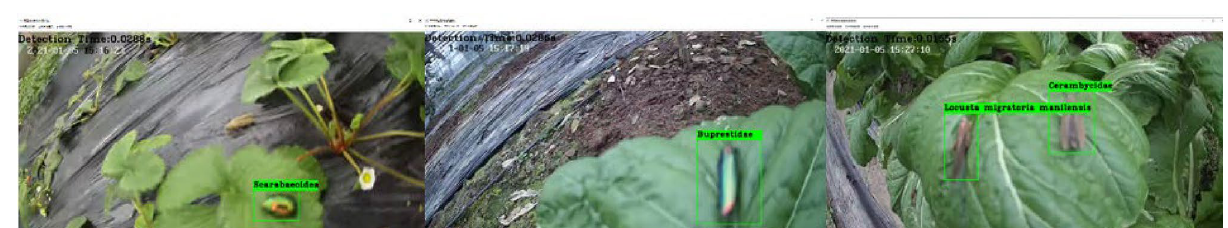
Figure 18. Test results n the laboratory with IP camera. Note : The first picture was a test result with a single insect, the second picture was a test result with insects and the third picture was a test result with multi-type insects.